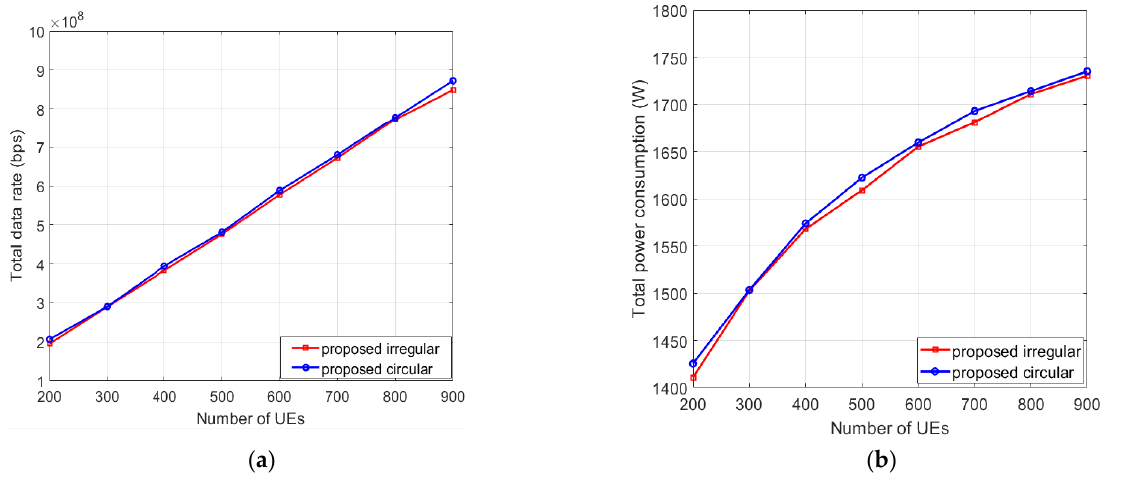
Figure 8. For the case of the circular center zone and the case of the center zone having the same irregular shape as the SC: ( a ) total data rate; ( b ) total power consumption.